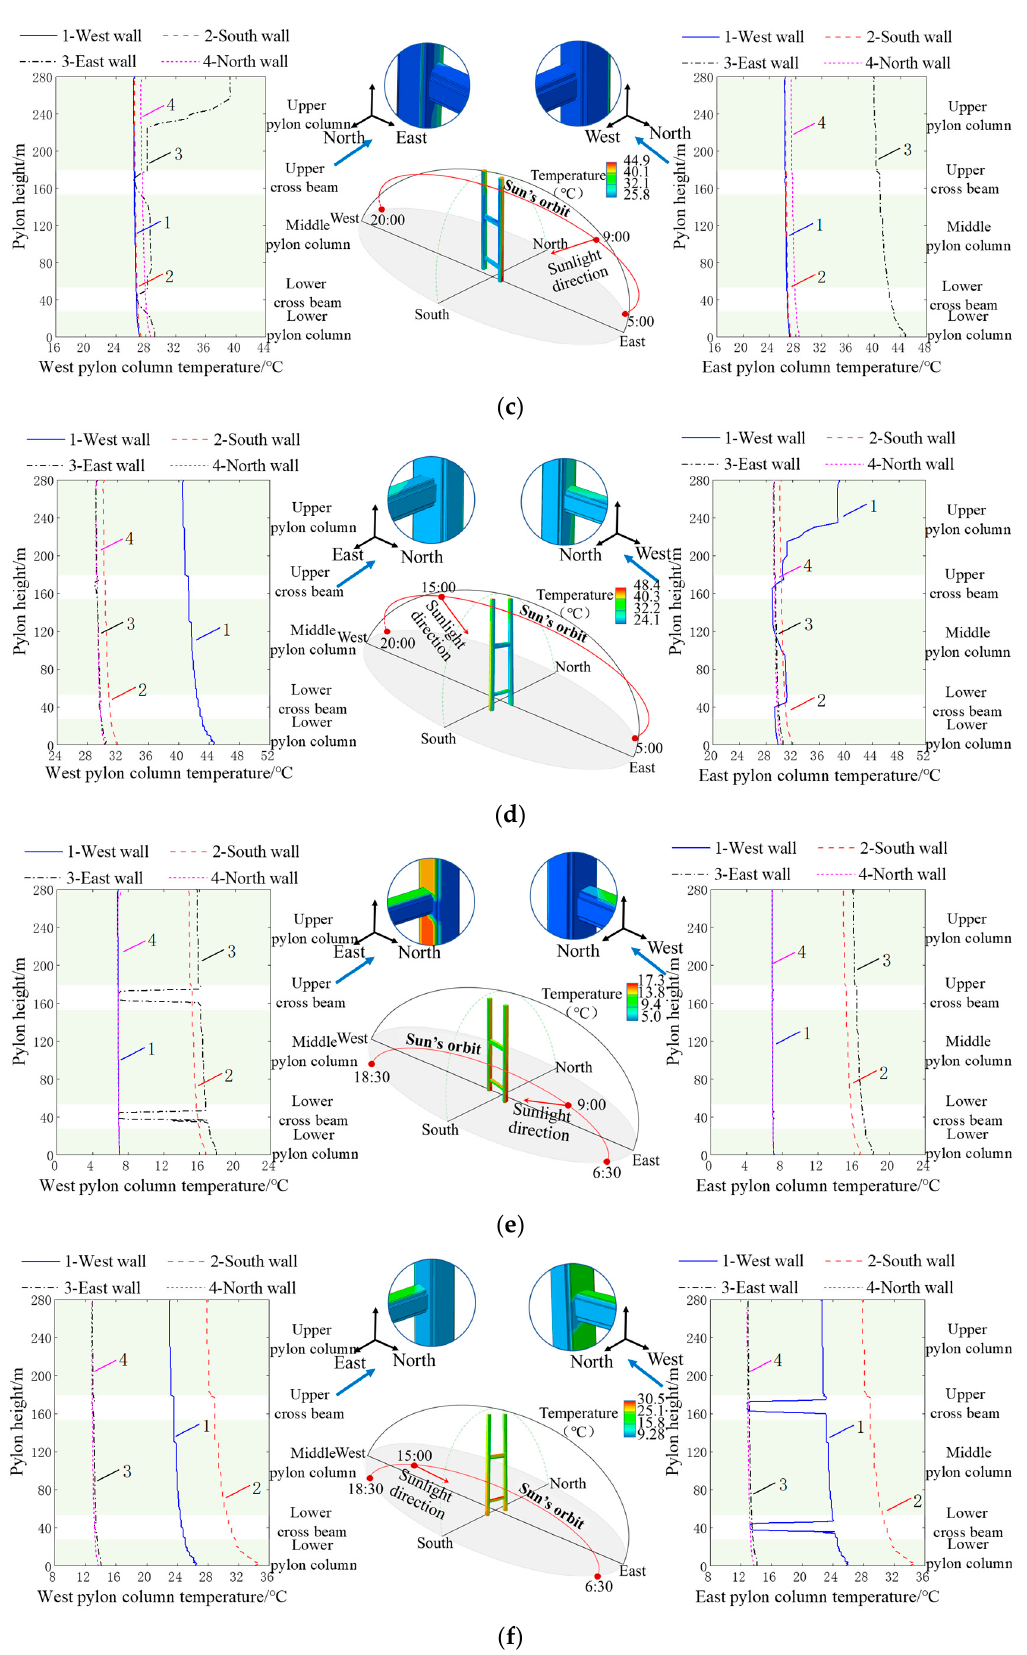
Figure 15. Vertical temperature distribution of bridge pylon: ( a ) Spring (Autumn)-9:00. ( b ) Spring (Autumn)-15:00. ( c ) Summer-9:00. ( d ) Summer-15:00. ( e ) Winter-9:00. ( f ) Winter-15:00.